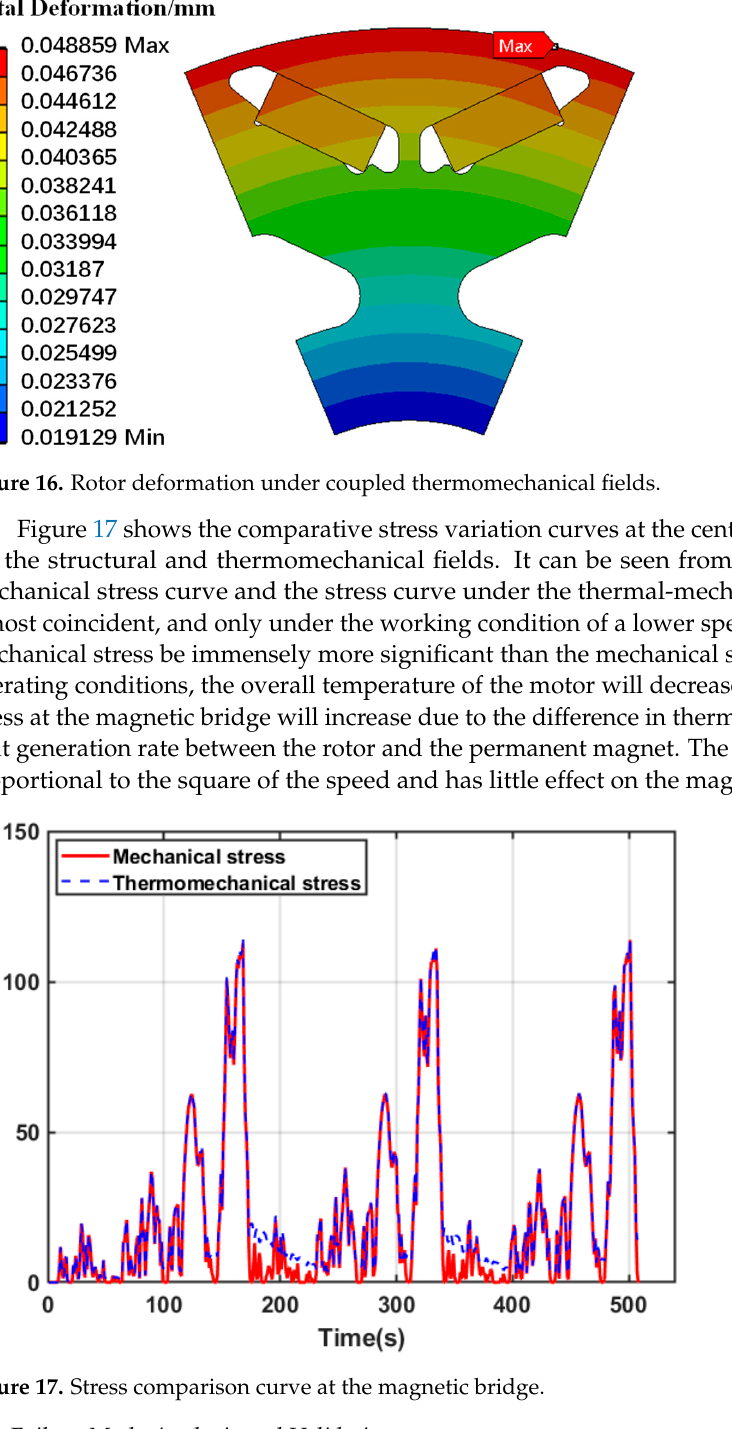
Figure 16. Rotor deformation under coupled thermomechanical fields.